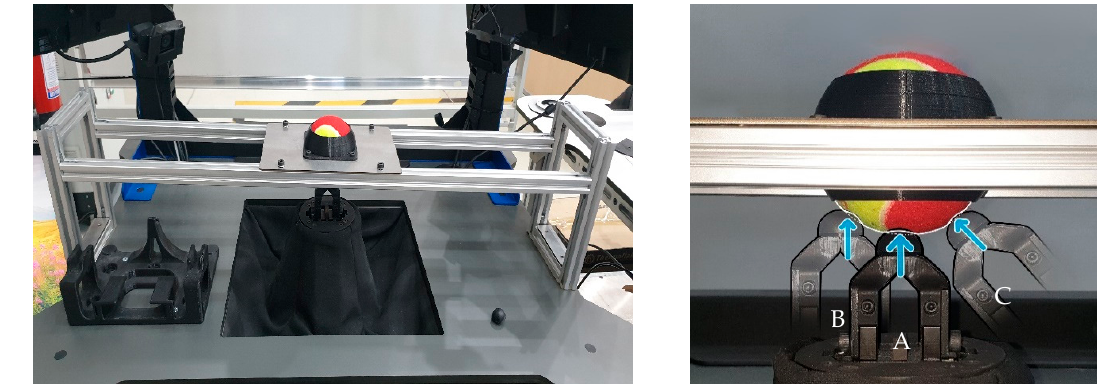
Figure 7. Test rig for measuring force versus deflection.